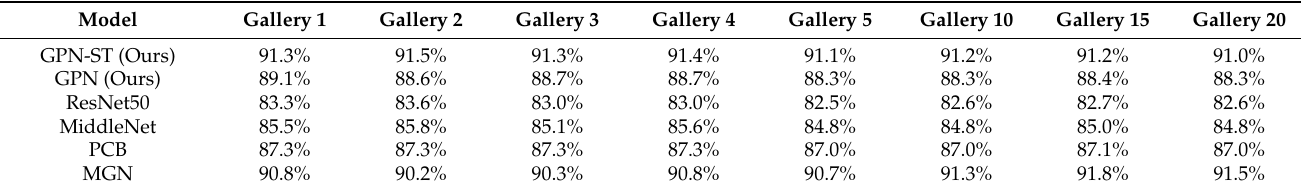
Table 3. mAP of different models in different gallery sets (%).